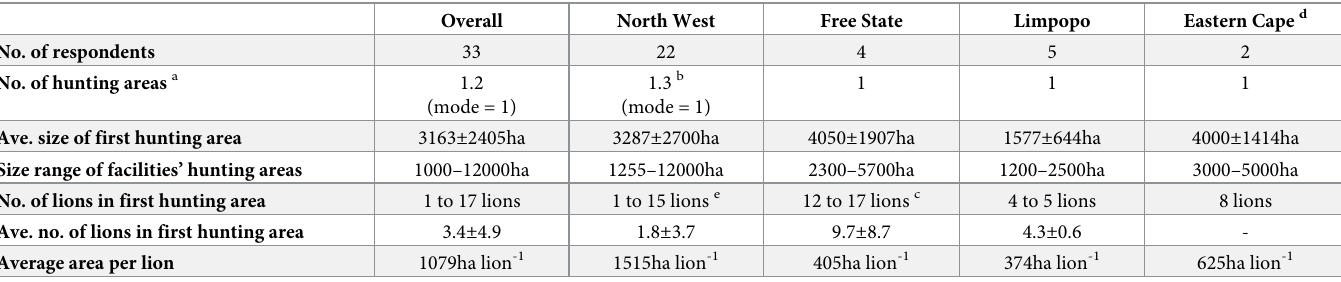
Table 3. The mean ( ± SD) size of hunting areas set aside on the properties of 33 respondents, and the number of lions per camp. Results correspond to Question